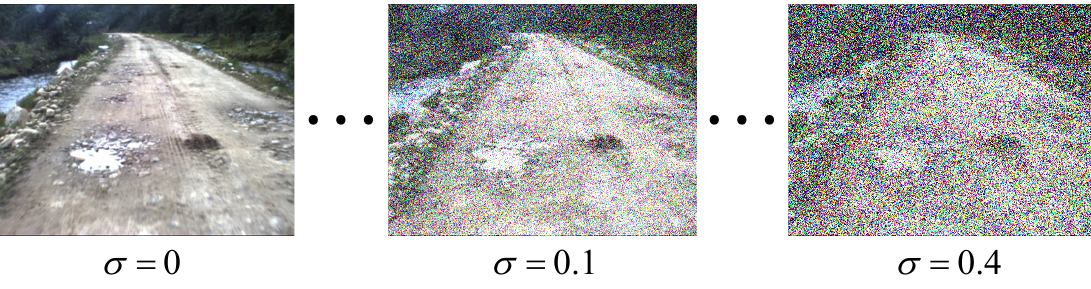
Figure 21. Illustration of the noise sensitivity evaluation.